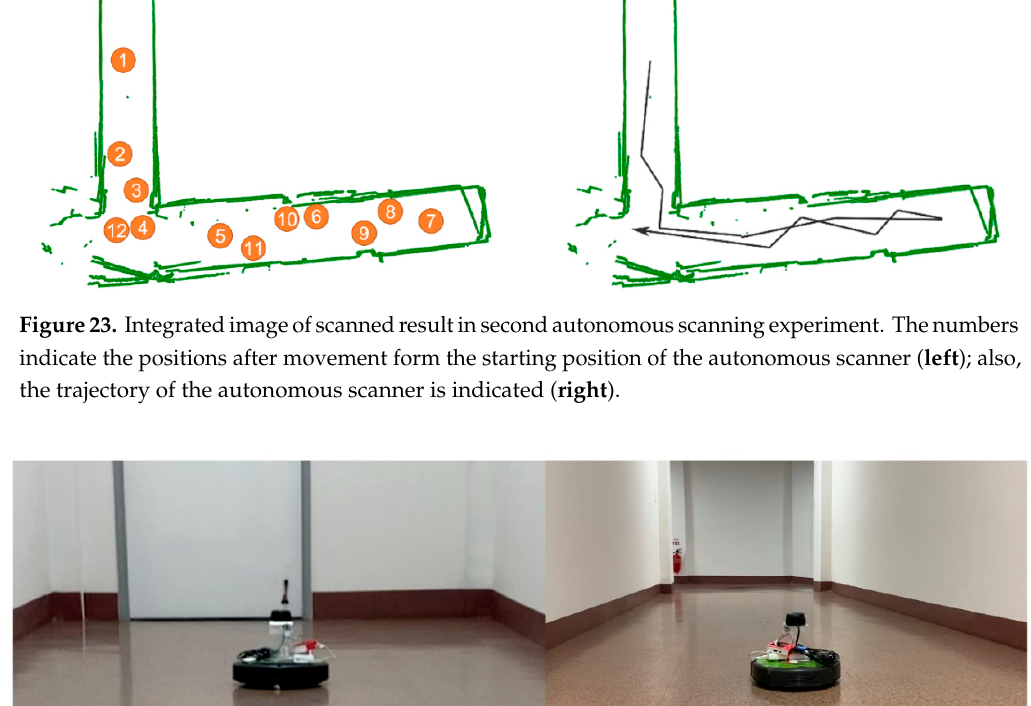
Figure 24. Initial position in indoor space where second autonomous scanning experiment was performed. Front view of autonomous scanner ( left ); backward view of autonomous scanner ( right ). Processes 2020 , 8 , x FOR PEER REVIEW